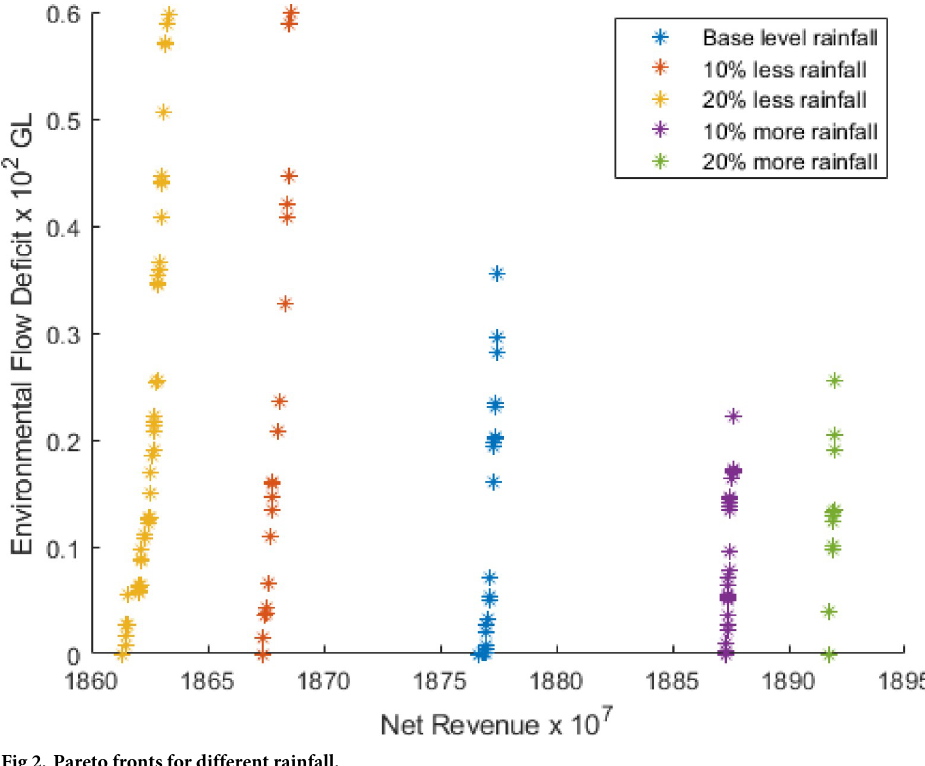
Fig 2. Pareto fronts for different rainfall.